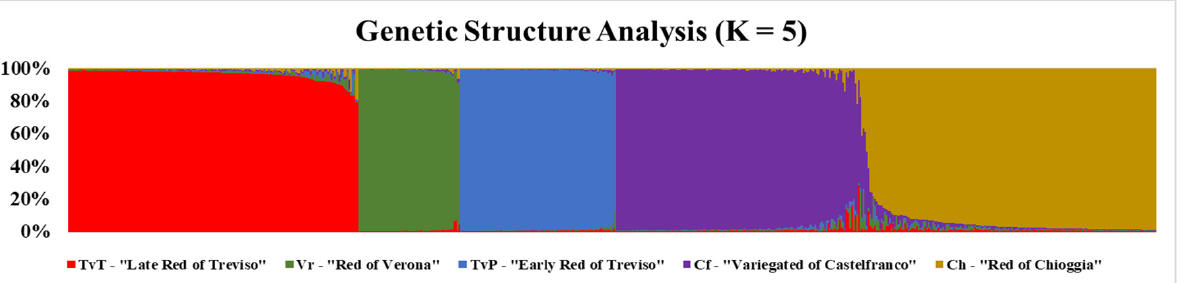
Figure 3. Genetic structure analysis of the radicchio core collection. Identified most likely value of K = 5. Clusters and samples’ memberships agree with the biotype of radicchio to which they belong.